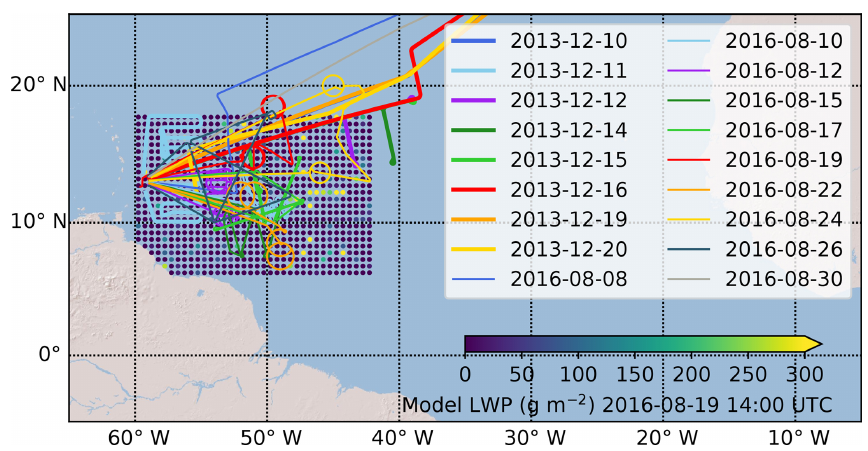
Figure 1. NARVAL1 (thick lines) and NARVAL2 (thin lines) flight patterns. The study area of interest is depicted by subsampled ICON LWP from 19 August 2016 14:00UTC. A grid point is shown every 0.5 as present in the retrieval